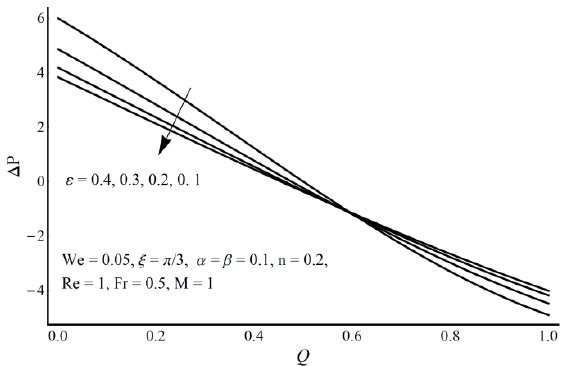
Coatings 2020 , 10 , x; doi: FOR PEER REVIEW Figure 6. Pressure rise per wavelength at various values of ε. Figure 6. Pressure rise per wavelength at various values of ε .